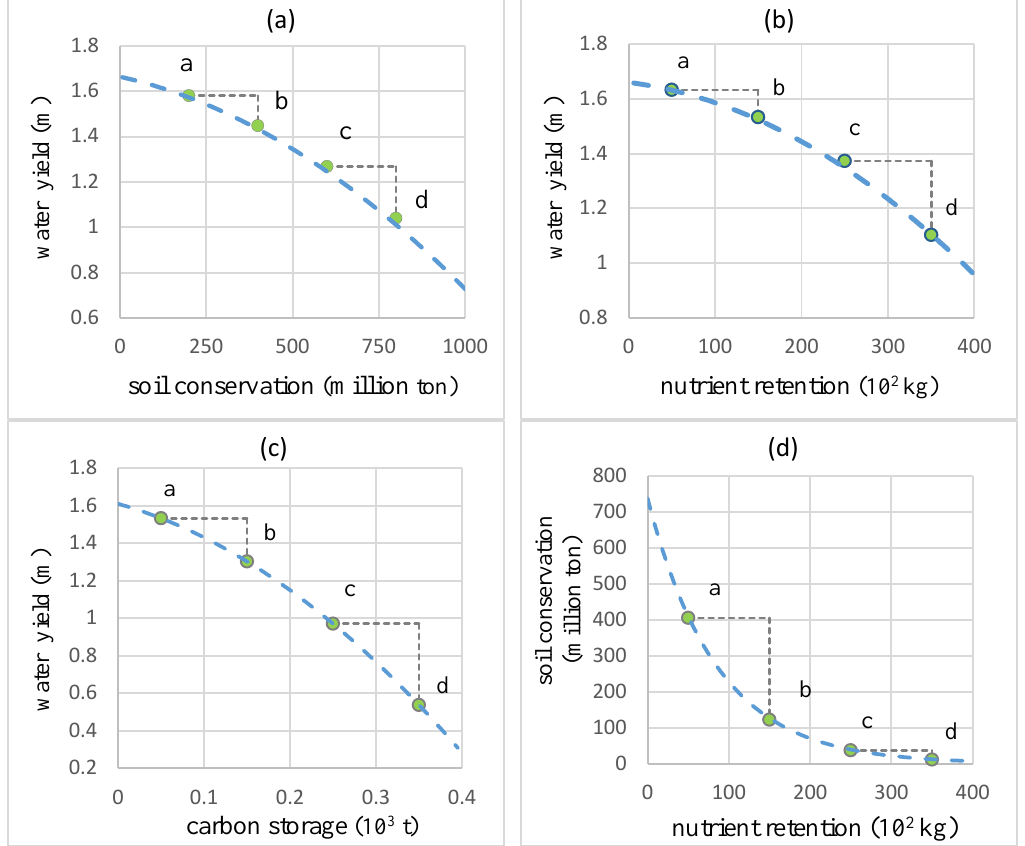
Figure 9. Production possibility frontier curve for soil conservation and water yield ( a ); production possibility frontier curve for nutrient retention and water yield ( b ); production possibility frontier curve for carbon storage and water yield ( c ); production possibility frontier curve for nutrient retention and soil conservation ( d ). Water 2018 , 10 , x FOR PEER REVIEW